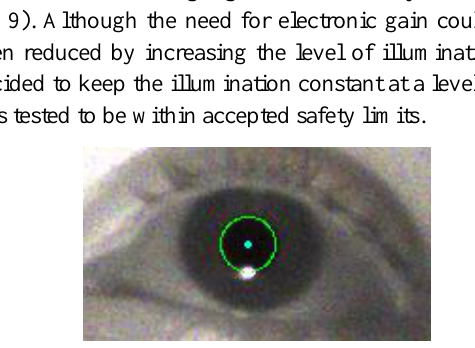
Table 2. Accuracy and precision for a range of sampling